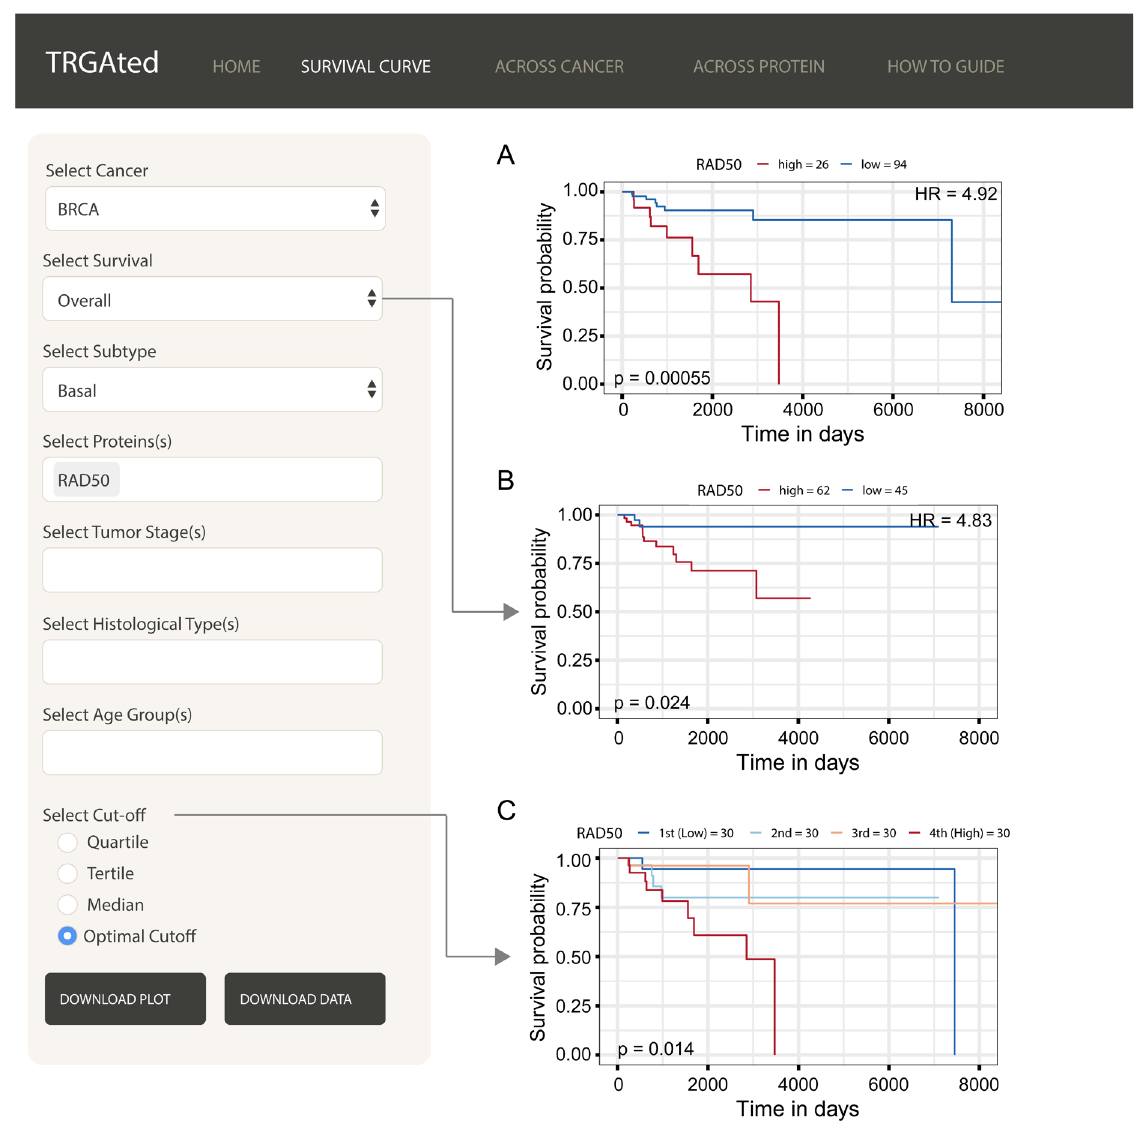
Figure 2. Generating survival curves. The interface shows an example of an overall survival curve for the RAD50 protein in the basal subtype of breast cancer using the optimal cutpoint ( A ). Disease-specific survival, disease-free interval, and progression-free interval can also be selected ( B ). The cutpoint can be varied to separate samples based on protein level into quartiles, tertiles, medians or separating into two groups based on the lowest p-value ( C ).